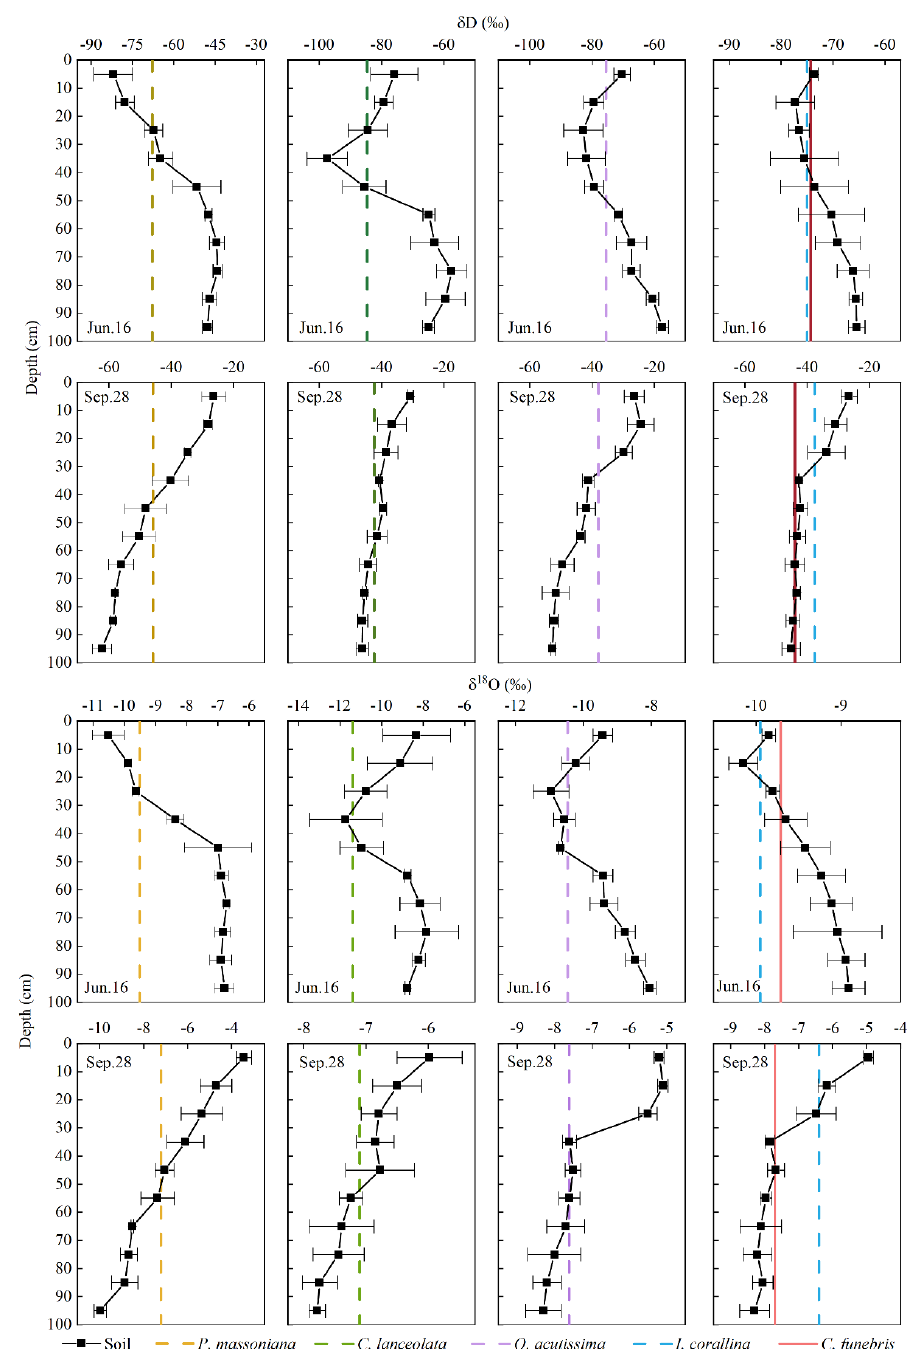
Figure 8. Seasonal δ D and δ 18 O variations of soil and xylem water in P. massoniana , C. lanceolata , Q. acutissima , I. corallina and C. funebris . Error bars represent the standard deviation ( N = 3). Error! Reference source not found. shows that in the wet season, the intersection of xylem water 𝛿𝐷 value and soil water 𝛿𝐷 value (10–40 cm) was consistent with the inter- section of 𝛿 (cid:2869)(cid:2876) 𝑂 of stem water and soil water (10–40 cm) of P. massoniana ; the intersection